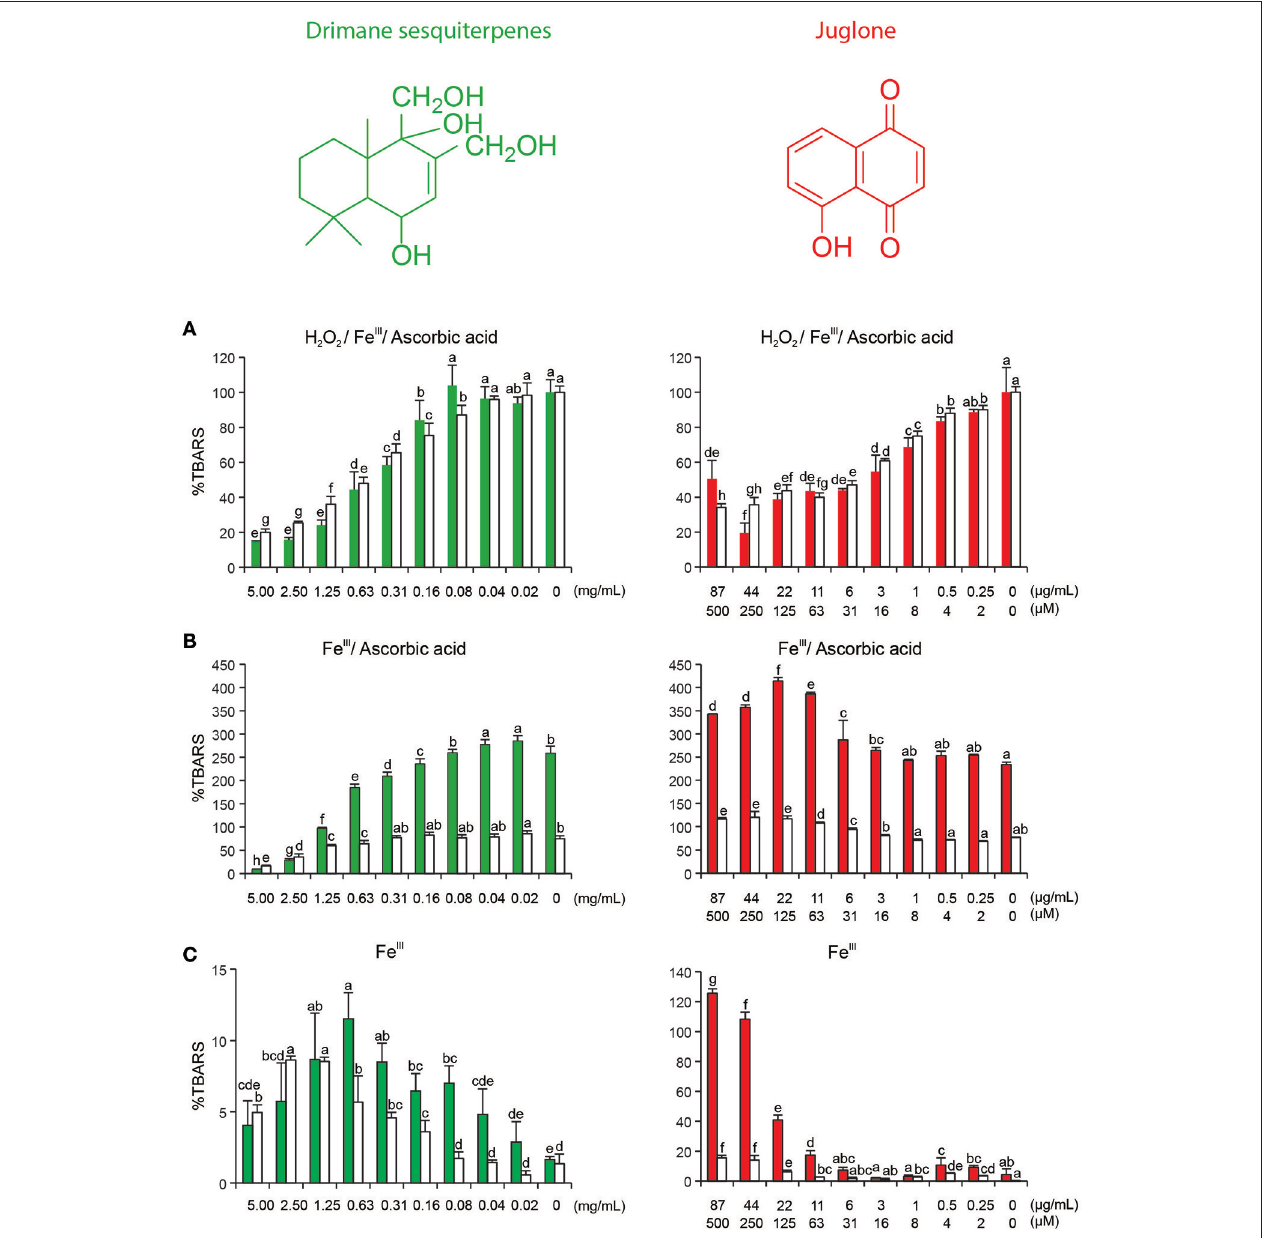
FIGURE 3 | Drimane sesquiterpene root combined extract (representative structure) and naphthoquinone juglone in variants of deoxyribose degradation assay; TBARS, thiobarbituric acid reactive species that arise following deoxyribose degradation; (A) H 2 O 2 , ascorbic acid, and FeCl 3 , the classical setup; (B) ascorbic acid and FeCl 3 , testing if the assayed compound or extract can reduce O 2 to H 2 O 2 ; (C) FeCl 3 , testing testing if the assayed compound or extract can perform the complete reduction from O 2 to OH; red bars, iron added as FeCl 3 (iron can coordinated the test compound or extract components); white bars: iron added as Fe(III)–EDTA complex (iron remains in the complex with EDTA). All assays were performed in triplicates and replicated at least once. Bars represent mean + standard deviation, letters indicate 95% Duncan